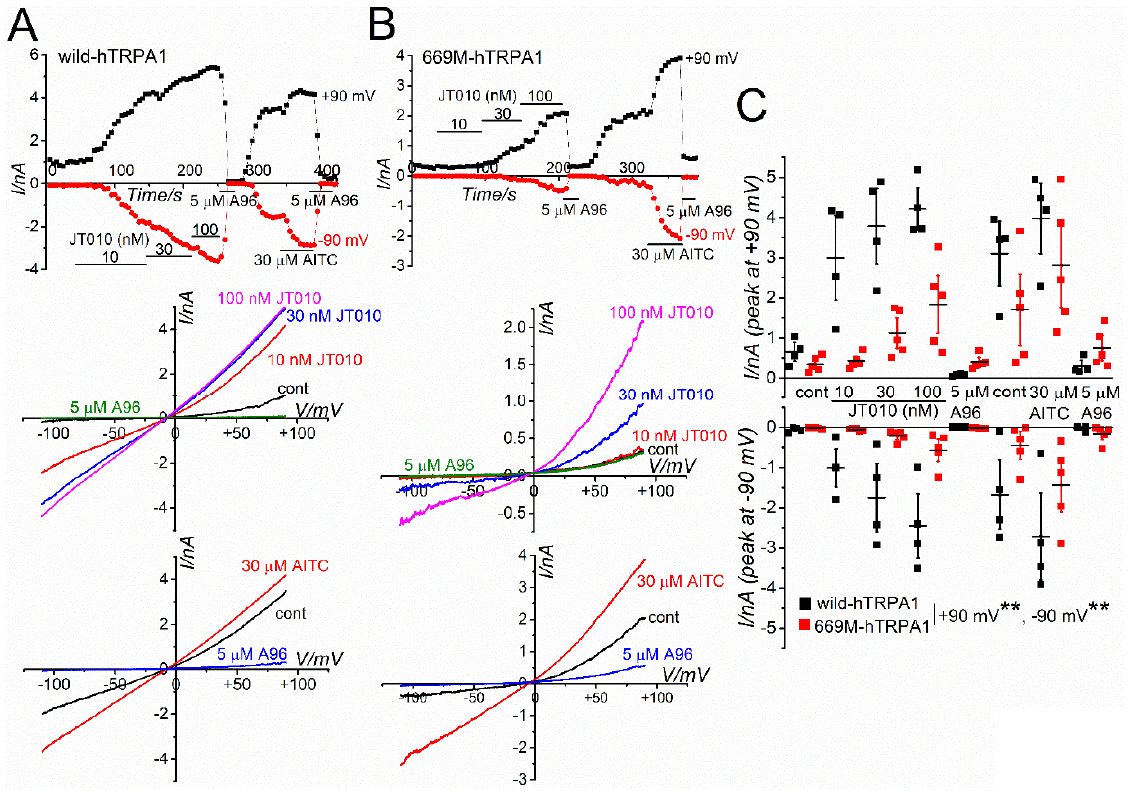
Figure 5. Critical importance of F669 for JT010-induced hTRPA1 response. ( A – C ) JT010 (10 to 100 nM)- and AITC (30 μ M)-induced currents at − 90 and +90 mV were compared between hTRPA1 ( A ) and 669M-hTRPA1 ( B ), and are summarized ( C , four-five independent experiments). Following agonist treatment, 5 μ M A96 was added to block TRPA1 channel current components. In the lower panel of ( A ) and ( B ), I-V relationships under each experimental condition are shown. Cells were superfused with SBS without Ca 2+ and dialyzed with Cs-aspartate rich pipette solution including 0.3 μ M Ca 2+ . Ramp waveform voltage pulses from − 110 to +90 mV for 300 ms were applied every 5 s. Two-way ANOVA (+90 mV): ** p < 0.0001, F = 33.3 (hTRPA); ** p < 0.0001, F = 17.1 (drugs); ** p = 0.00045, F = 4.54 (interaction). Two-way ANOVA ( − 90 mV): ** p < 0.0001, F = 28.6 (hTRPA); ** p < 0.0001, F = 11.4 (drugs); ** p = 0.00846, F = 3.06 (interaction). Vertical bars = SEM.